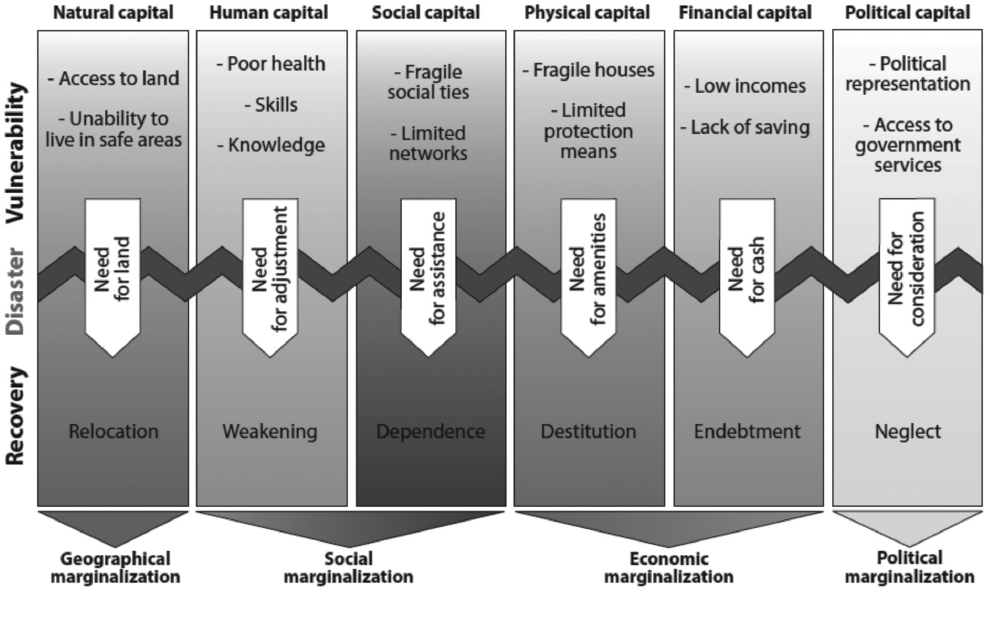
Fig 6. Livelihoods, pre-disaster vulnerability, post-disaster recovery and the process of